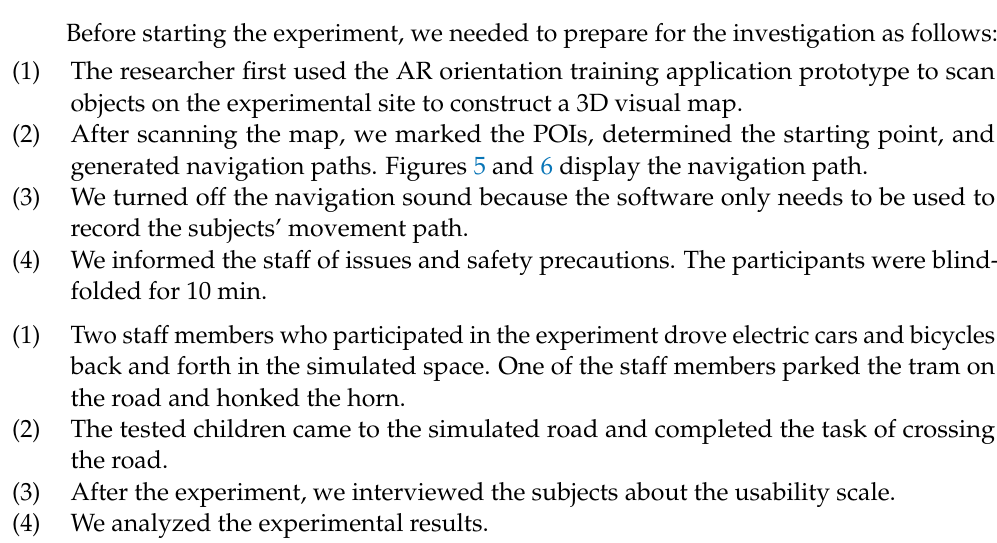
Figure 9. Path map of the inter-group comparison experiment.